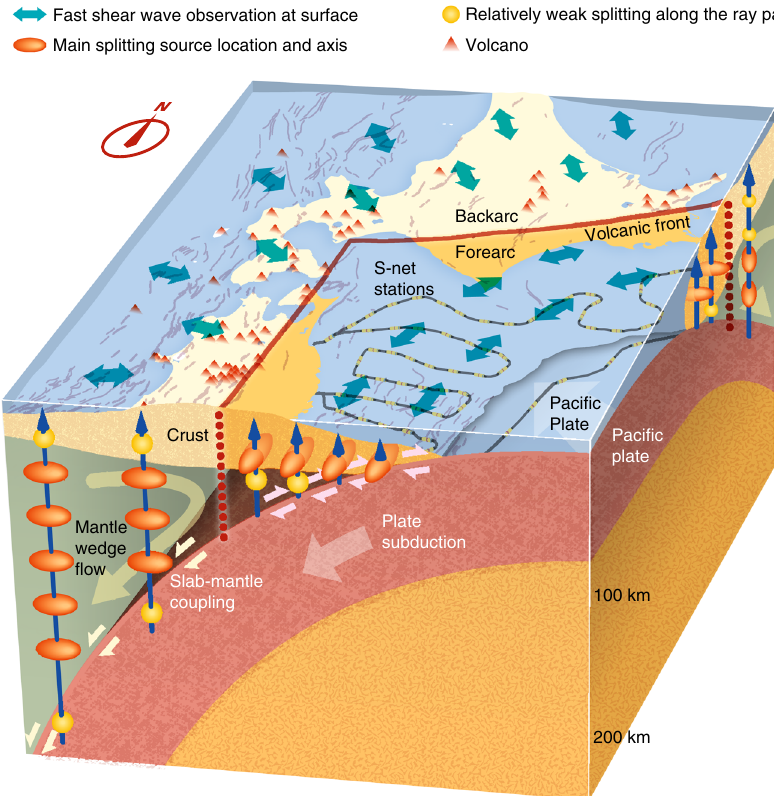
Fig. 4 Schematic illustration of shear-wave anisotropy in the Japan Trench subduction zone. Green double-headed arrows show the observation of the fast shear wave direction at the surface stations. Spheroids show the main location of the anisotropy along ray paths (blue arrows), with the longest axis indicating the fast direction. Spheres represent a lack of anisotropy. Grayline and cylinders show the S-net cable and OBSs, respectively. Redline and red dashed lines show the volcanic front and its deep extension. Pairs of opposite pink arrows show a slip of the subduction interface, but pairs of arrows with the same direction show the mantle material is coupled to, and travels with, the slab (interplate coupling). Triangles and thin gray lines represent volcanoes and active faults,